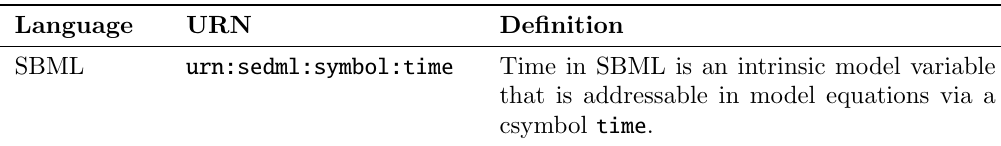
Table 3.3: Predefined symbols in SED-ML. The latest list of symbols is available from http://sed-ml. org